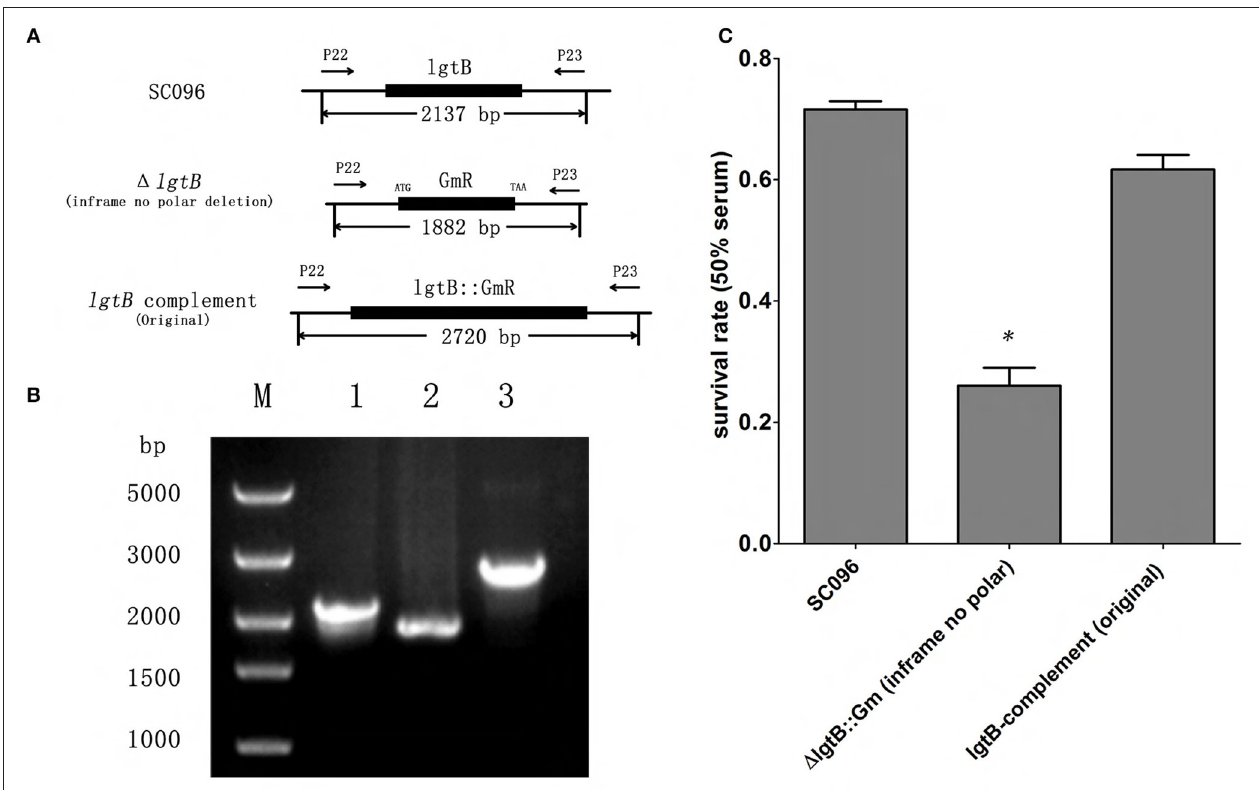
FIGURE 5 | Construction and verification of lgtB in-frame non polar mutant and the original complemented strain. (A) Schematic of lgtB in-frame non polar mutant and the original complemented strain. The lgtB in-frame non polar mutant was constructed by replacing lgtB with Gm R gene from ATG to TAA codon. The original complemented strain was constructed by inserting the intact lgtB gene follow by Gm R gene into previous constructed 1 lgtB ::Kan R strain in order to confirm the phenotype of the previous lgtB ::Kan R mutant. (B) PCR analysis verifying the lgtB in-frame non polar mutant and the original complemented strain. Primers P22 and P23 were used to amplify the locus region of lgtB from the wild type SC096 (lane 1), the lgtB in-frame non polar strain (lane 2), and the original complemented strain (lane 3); lane M shows a 5Kb DNA molecular marker. (C) Survival of lgtB in-frame non polar mutant and the original complemented strains treated with 50% porcine serum. The lgtB in-frame non polar mutant showed significantly increased susceptibility to serum compared with the wild type strain SC096 ( p < 0.01) with 50% porcine serum, while the original complemented strain restored the serum resistant phenotype. Error bars represent the standard deviation of three independent experiments. The asterisks indicate that the survival of bacteria in serum was statistically different ( p < 0.01) from that of the wild-type SC096 strain as judged by the Student t- test.